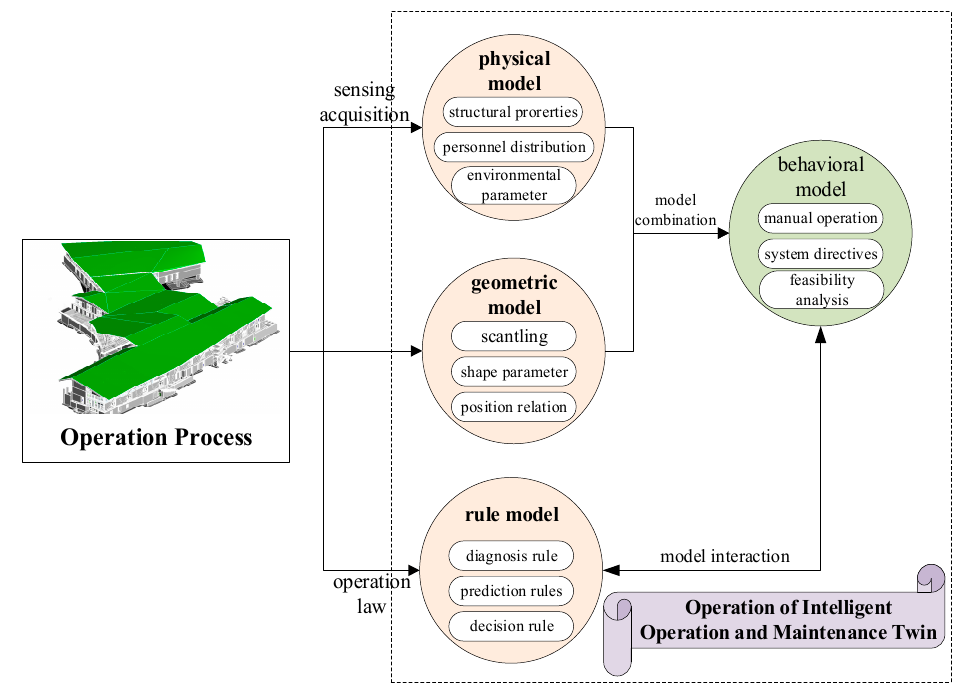
Figure 6. Efficient operation of twin agents for O&M.